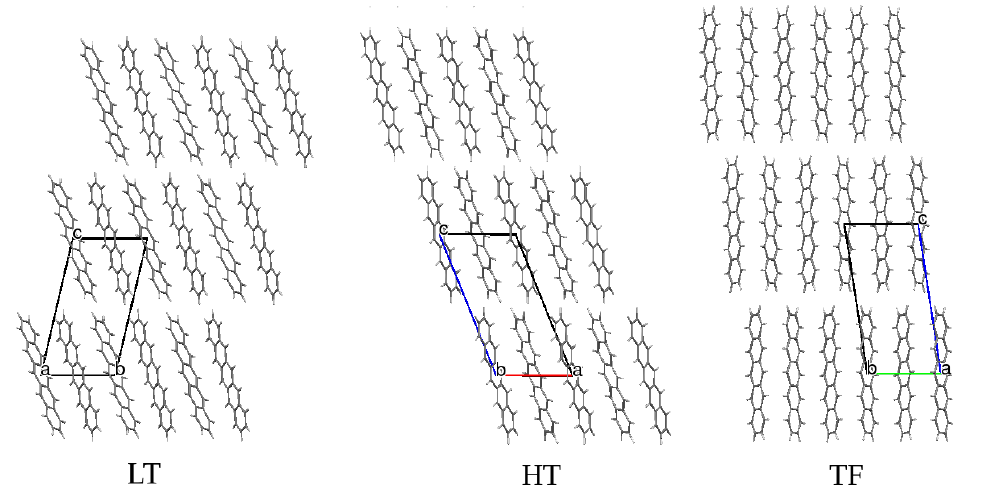
Figure 1. Structure of the low temperature (LT), high temperature (HT) and thin-film (TF) polymorphs of